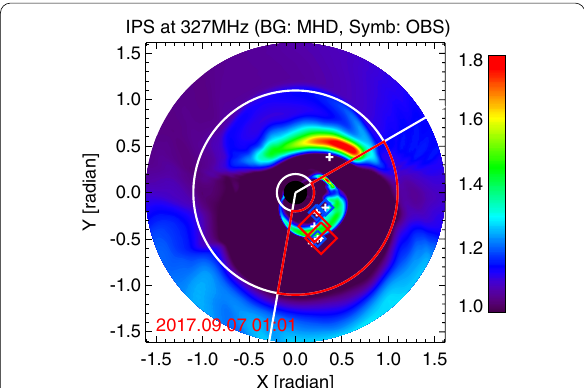
Fig. 1 Example distribution of the simulated IPS data. IPS g-value estimated by the SUSANOO projected onto the sky-plane. White circles and red lines indicate elongation and position angle range of the radio source used for the forecasting, respectively. The symbols indicate the IPS g -value observed by SWIFT from 01:00 UT to 02:00 UT. Crosses indicate all observed radio sources and diamonds indicate radio sources with the following g-values: 2.0 < g (red), 1.5 < g < 2.0 (green), and 1.2 < g < 1.5